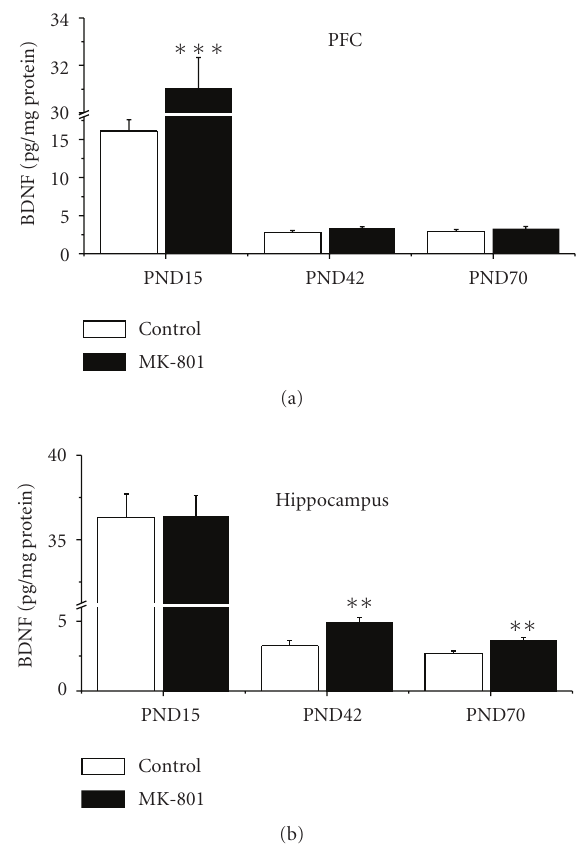
Figure 2: The influence of neonatal MK-801 treatment on BDNF concentrations in (a) PFC and (b) hippocampus on di ff erent post- natal days. ∗ , ∗∗ , ∗∗∗ P < . 05, P < . 01, P < . 001 respectively.